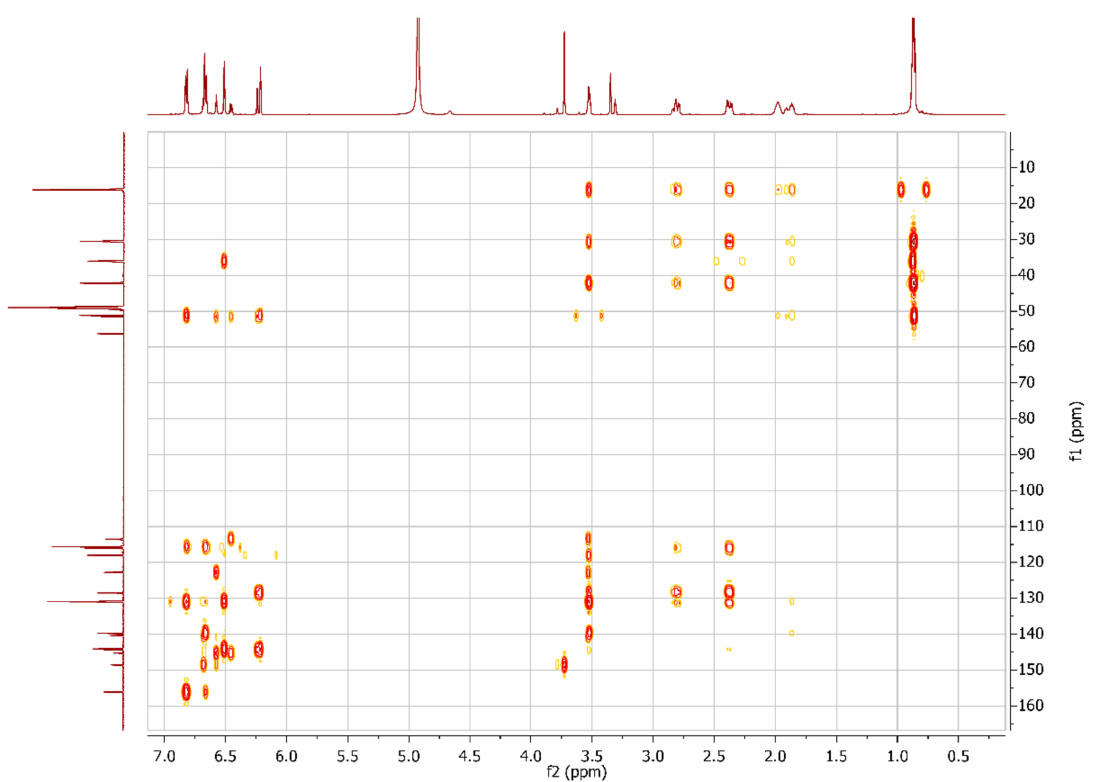
Figure A6. 1H-13C (HMBC) NMR (CD3OD, 600 MHz) of 32 3 (cid:48) -demethoxy-6-O-demethylisoguaiacin ( 1 ) and norisoguaiacin ( 2 )